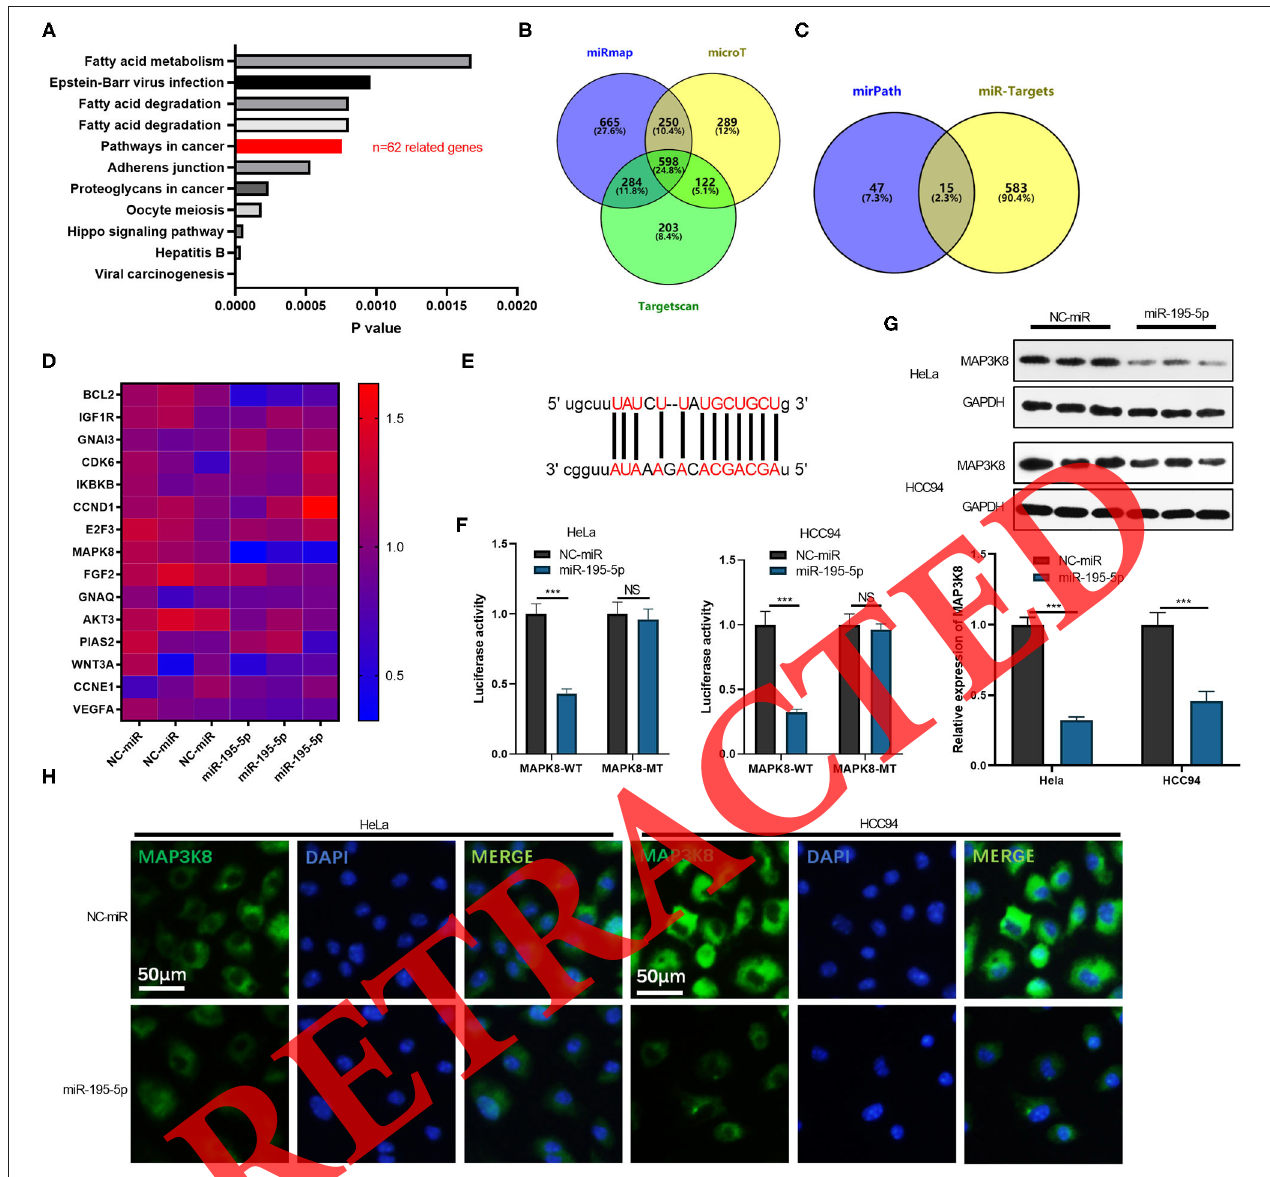
FIGURE 6 | MiR-195-5p targets MAP3K8. (A) The mirpath database (http://snf-515788.vm.okeanos.grnet.gr/index.php?r=mirpath) was used to predict the signal pathways regulated by miR-195-5p. (B) Through mirmap (http://mirnamap.mbc.nctu.edu.tw/), microT (https://omictools.com/diana-microt-cds-tool), and Targetscan (http://www.targetscan.org/vert_72/), miR-195-5p’s targeting molecule was predicted. (C) The miR-195-5p related molecules in mirpath, mirmap, microT, and Targetscan databases were analyzed by Venn diagram. (D) RT-PCR was performed to measure tumor gene expression after miR-195-5p overexpression. (E) Base pairing between miR-195-5p and MAPK8. (F) Dual luciferase activity experiments were applied to verify the relationship between miR-195-5p and MAPK8. (G) Western blot was taken to evaluate the protein level of MAP3K8 in over-expressing miR-195-5p and low-expressing miR-195-5p cells. (H) Cell